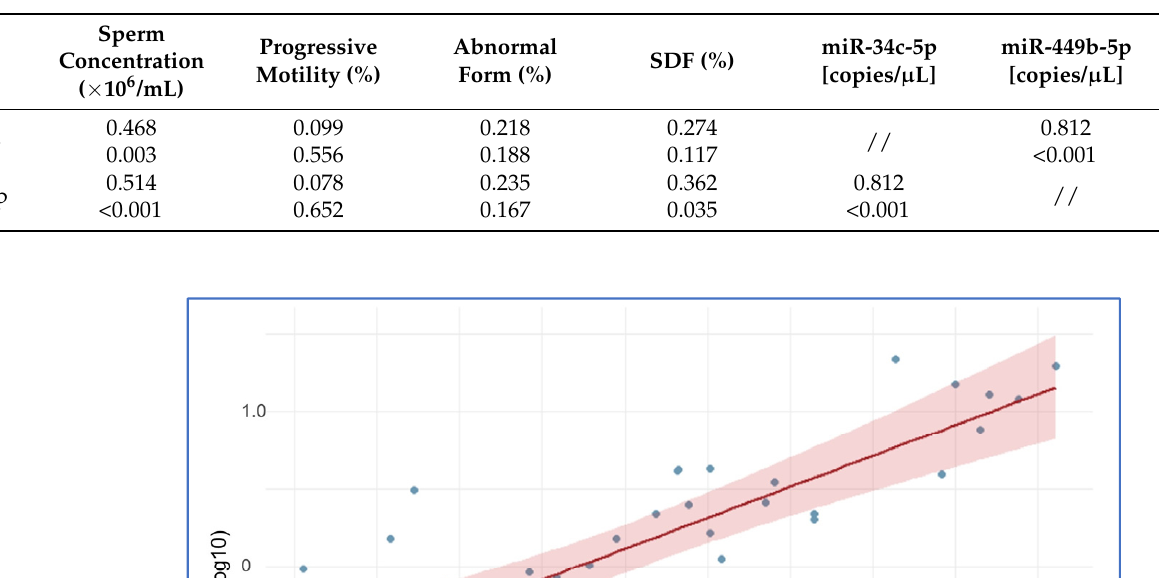
Table 10. Spearman’s correlation between miR-34c-5p, miR-449b-5p, and seminal characteristic.